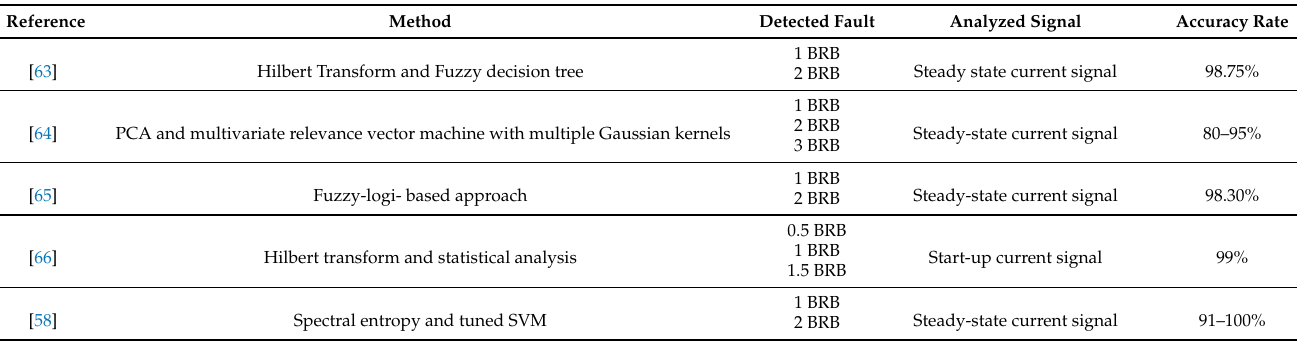
Table 3. Recent MCSAs based on artificial